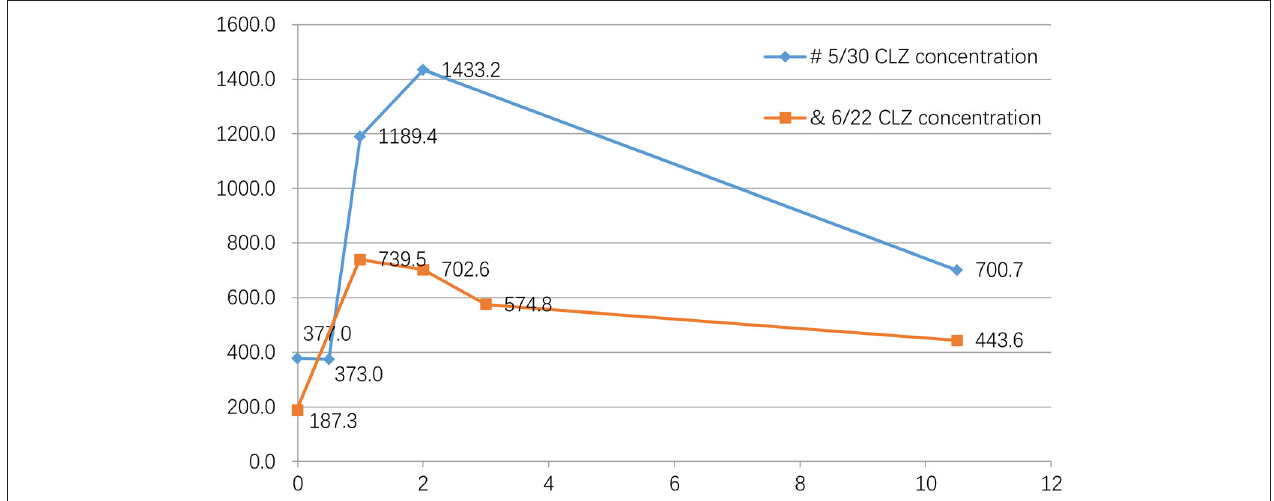
FIGURE 2 | Blood concentration of clozapine five times on the same day. #On May 30, we checked his CLZ blood concentration 5 times on the same day, and the results were as followed: 377.0ng/ml (before taking medicine), 373.0ng/ml (0.5h after taking CLZ), 1189.4ng/ml (1h after taking CLZ), 1433.2ng/ml (2h after taking CLZ), 700.7ng/ml (the following day at 6:30 AM, 10.5h after taking the drug). &On June 22, the results were as followed: 187.3ng/ml (before taking medicine), 739.5ng/ml (1h after taking CLZ), 702.6ng/ml (2h after taking CLZ), 574.8ng/ml (3h after taking CLZ), 444.6ng/ml (the following day at 6:30 AM, 10.5h after taking CLZ) ( Table 1 ; Figure 2